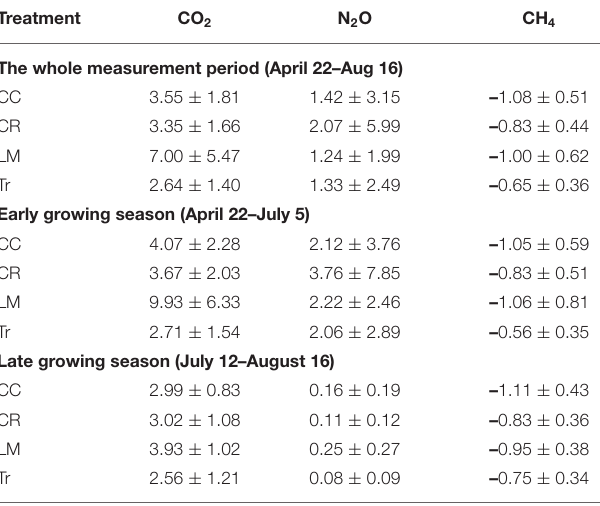
TABLE 2 | Mean transformed CO 2 flux ( n = 342) group comparisons from four treatments in 2018. Groups Difference ( µ mol